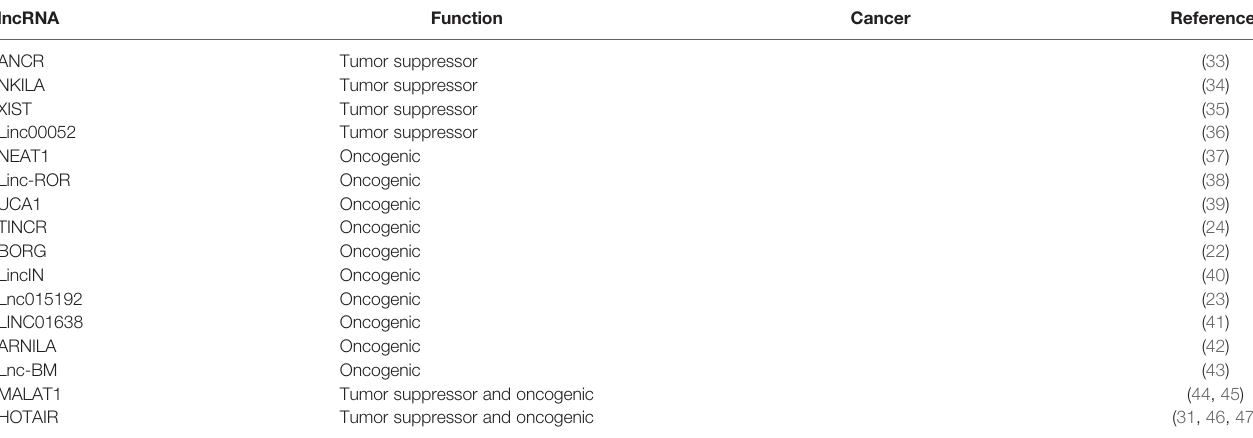
TABLE 1 | lncRNAs involved in breast cancer